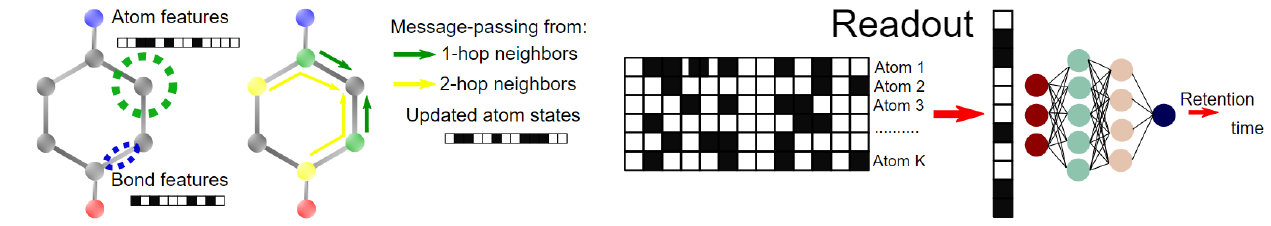
Figure 1. A general scheme of a message-passing neural network.